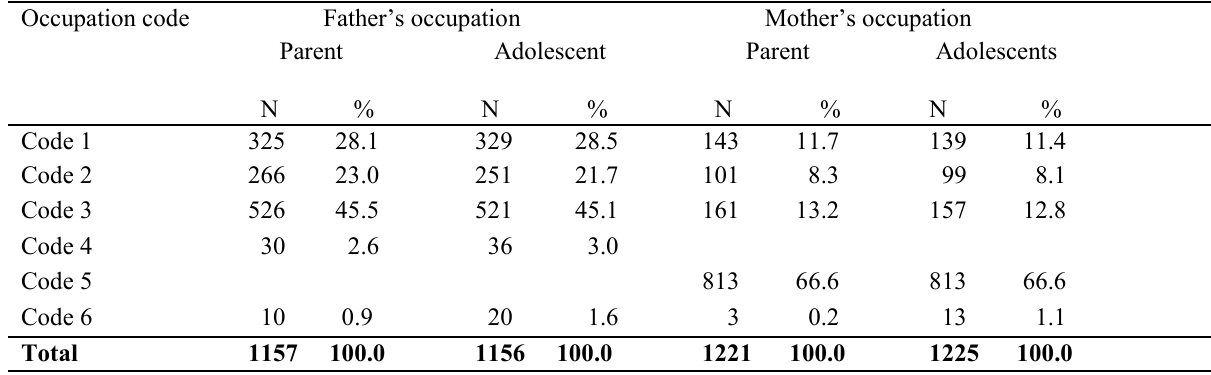
Table 1 Distribution of parents’ occupation status according to parents and adolescents